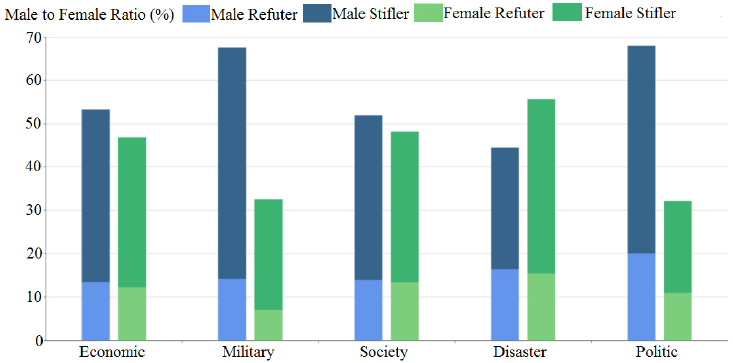
Figure 3. Male to female ratio in database.